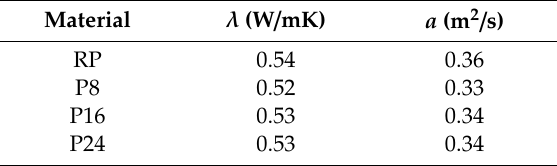
Table 4. Thermal conductivity of studied